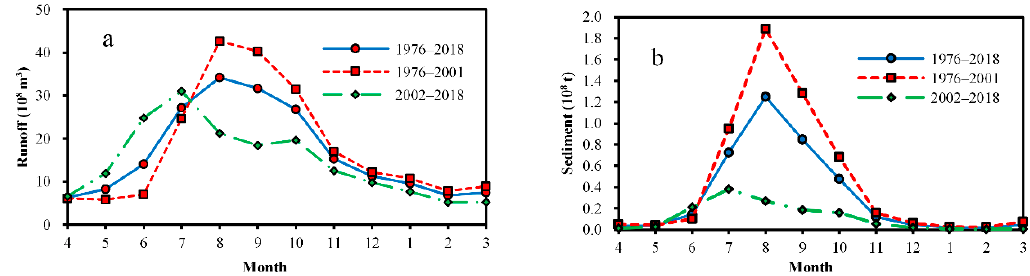
Figure 8. Monthly average runoff ( a ) and sediment ( b ) at the Linjin hydrometric station from 1976 to 2018.